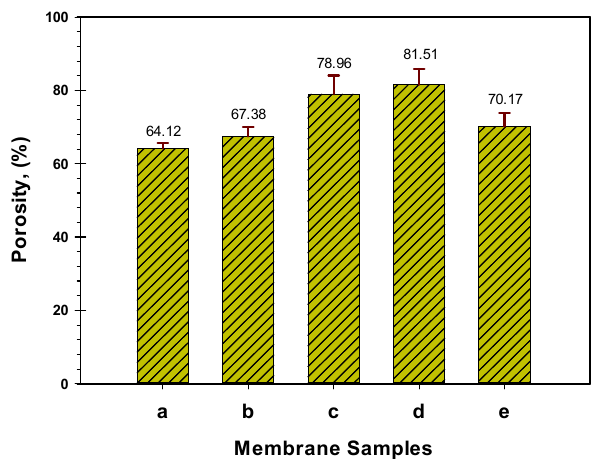
Figure 2. Porosity properties of neat (a), and modified membrane with varied NMO loading (b–e).